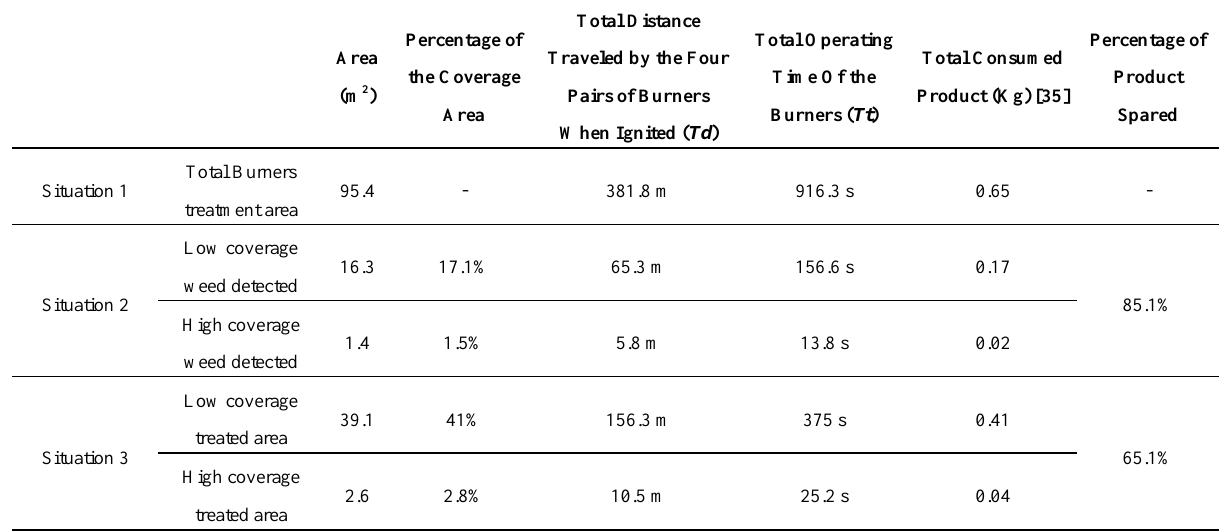
Table 7. Comparison of the use of product for selective weed